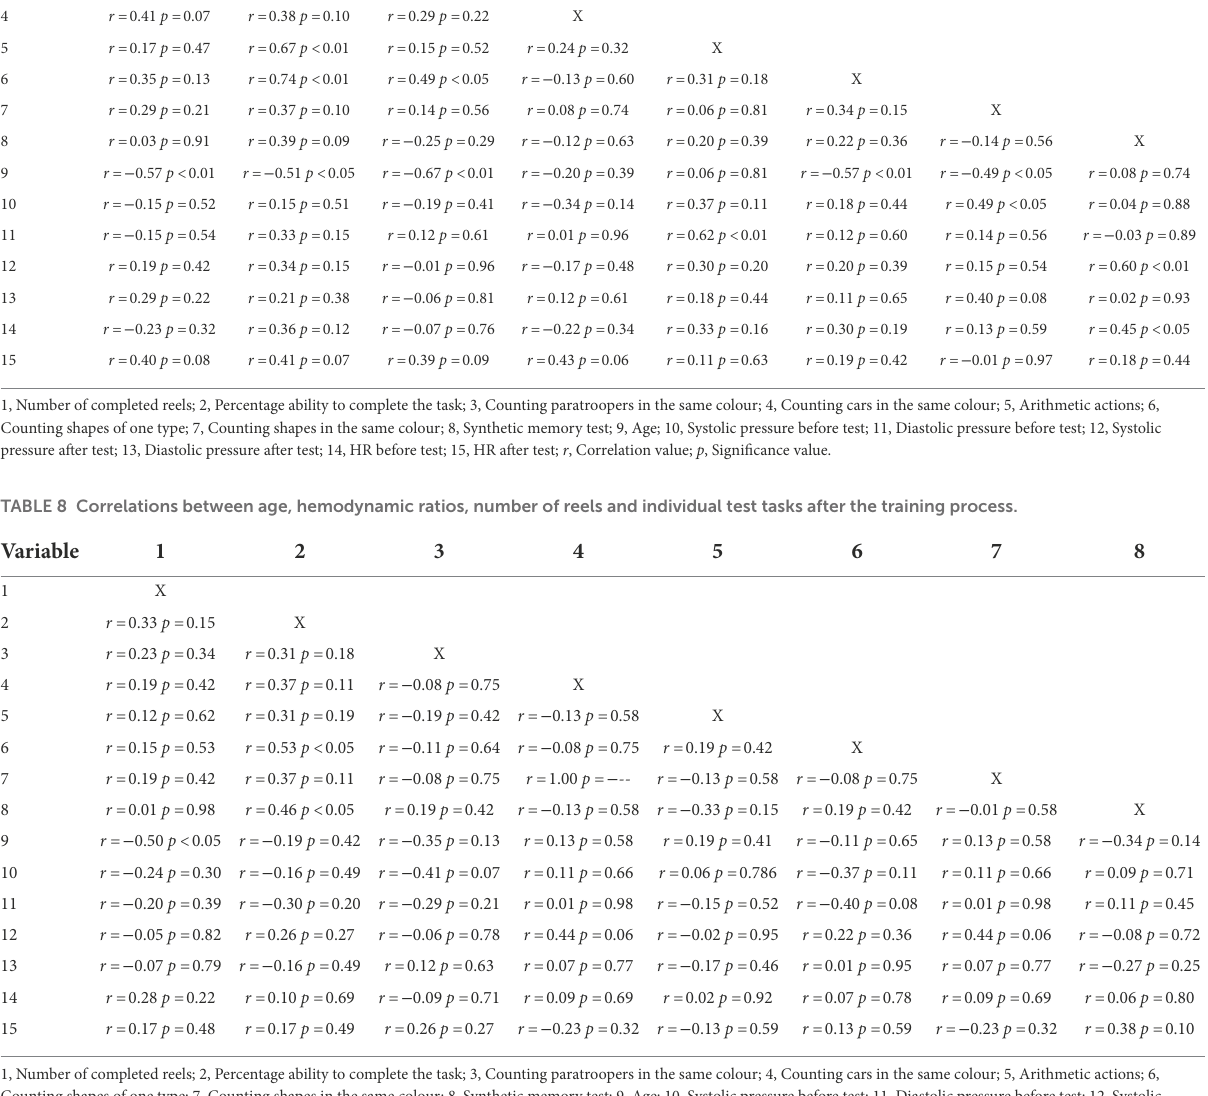
The results obtained during the second test (after the end of the training process) showed a negative, statistically significant correlation between the number of reels made and age (at p < 0.05; Table 8). A statistically significant positive correlation was observed between the percentage ability to complete all tasks and counting one type of shape (with p < 0.05) and a synthetic memory test (with p < 0.05; Table 8). It was found that the percentage ability to complete all tasks occurs in the same correlation with shape counting as before the training process, but it is at a lower statistical significance level. The other variables showed no statistically significant correlation (Table 8).